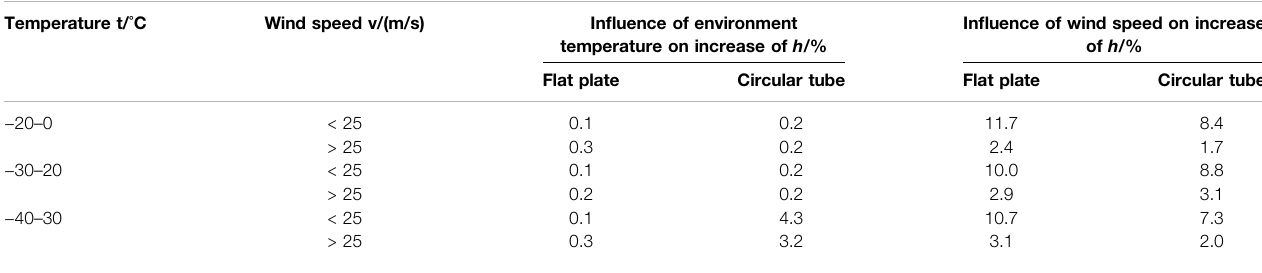
TABLE 1 | Simulation analysis results of the convective heat transfer coef fi cient. Temperature t/ ° C Wind speed